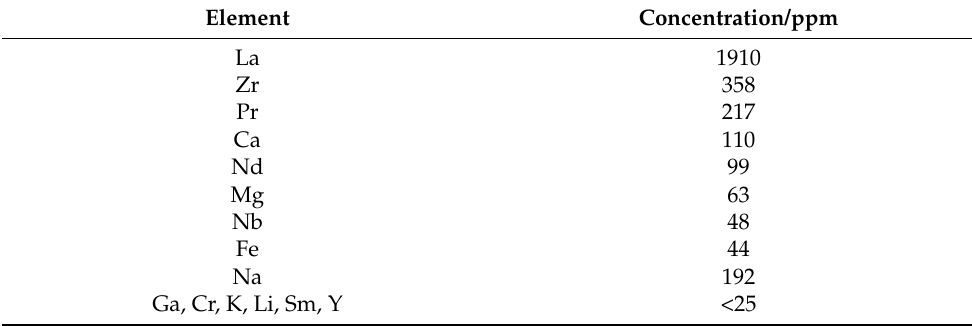
Table 1. Compilation of the ICP-OES analysis of a sintered CeO 2 pellet.